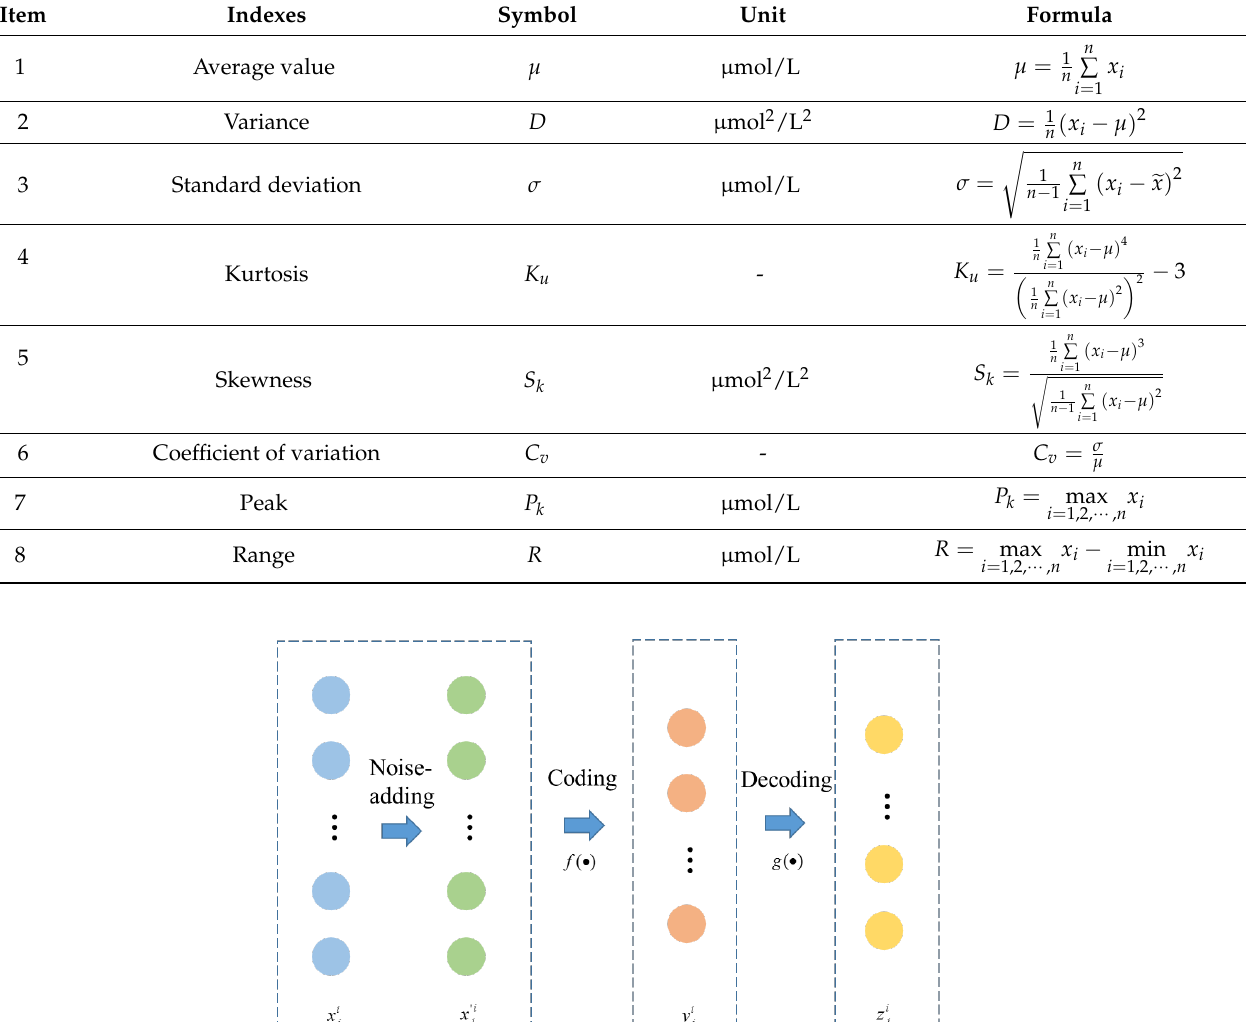
Table 4. Characteristic indexes of fNIRS signal.